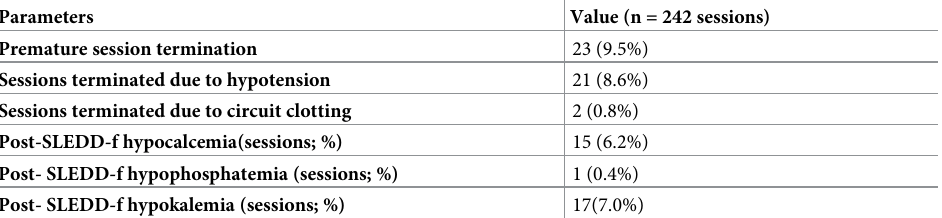
Table 3. Post SLEDD-f